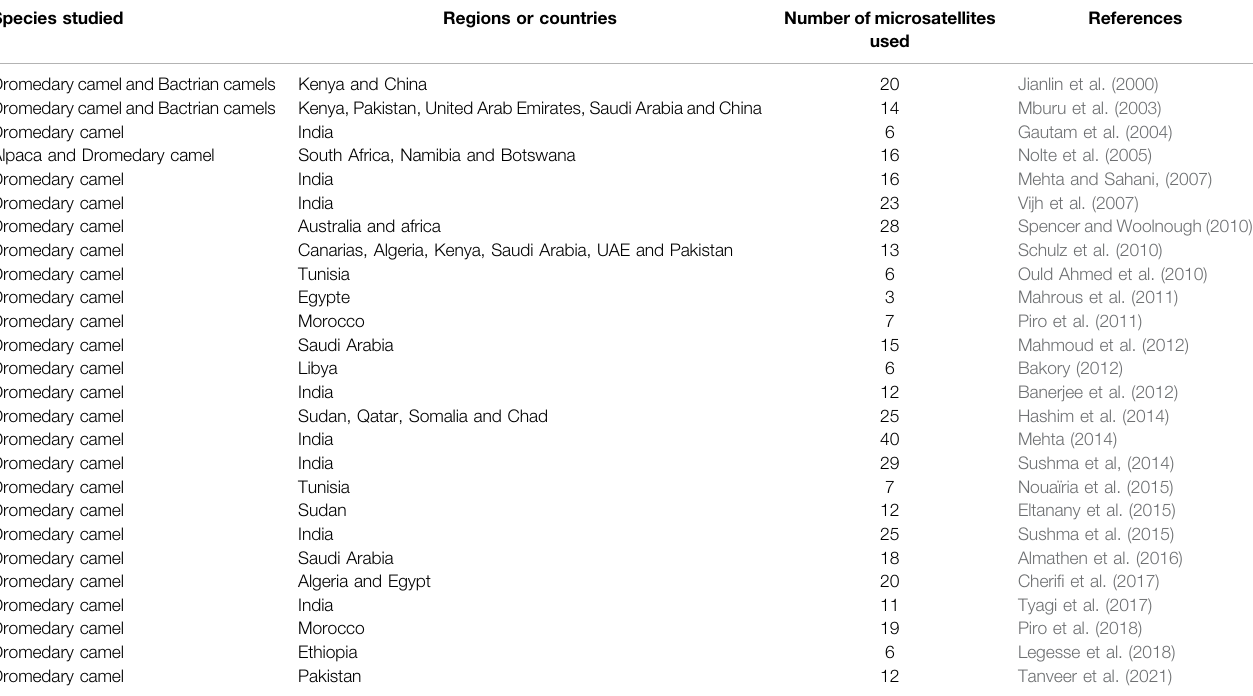
TABLE 2 | Main studies using microsatellites realized in dromedary camels for the evaluation of genetic diversity. Species